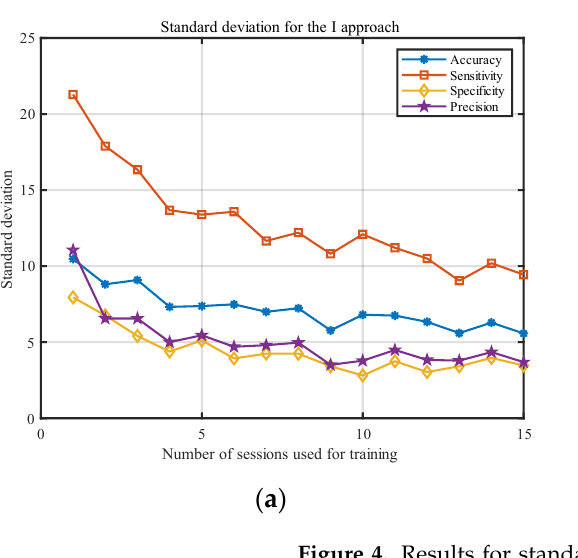
Figure 3. Results for classification measures, according to the number of sessions used for training, averaged over all individuals for the ( a ) I approach and ( b ) II approach.